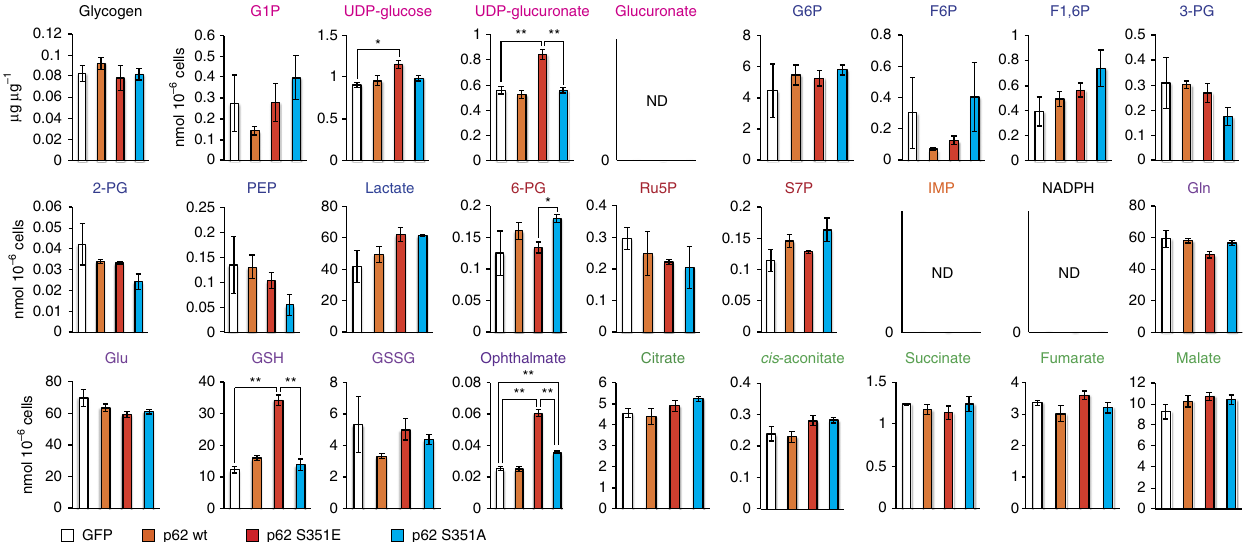
Figure 3 | Metabolic intermediates in HCC cells harbouring phospho-mimetic p62. Quantification of metabolic intermediates in Huh7 cells expressing GFP, wild-type, S351E or S351A. The experiments were performed three times. Data are presented as means ± s.e. * P o 0.05, ** P o 0.01 as determined by the Welch t